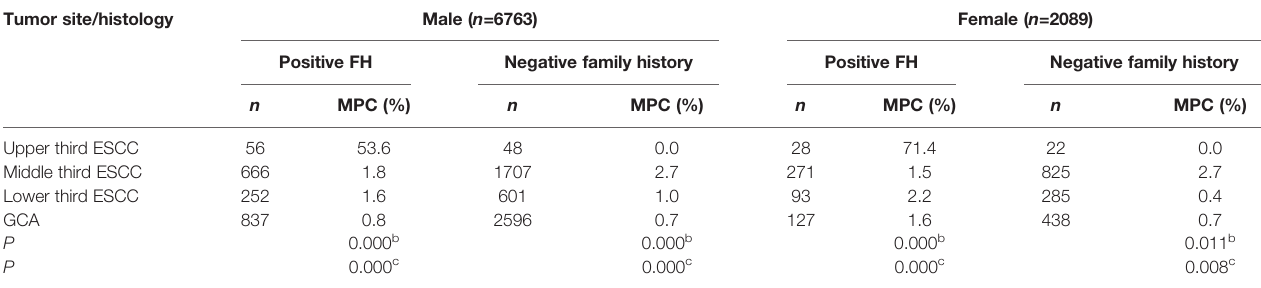
TABLE 3 | Proportion of MPC associated with 8852 a separate ESCC and/or GCA by tumor site, sex, and family history of upper gastrointestinal